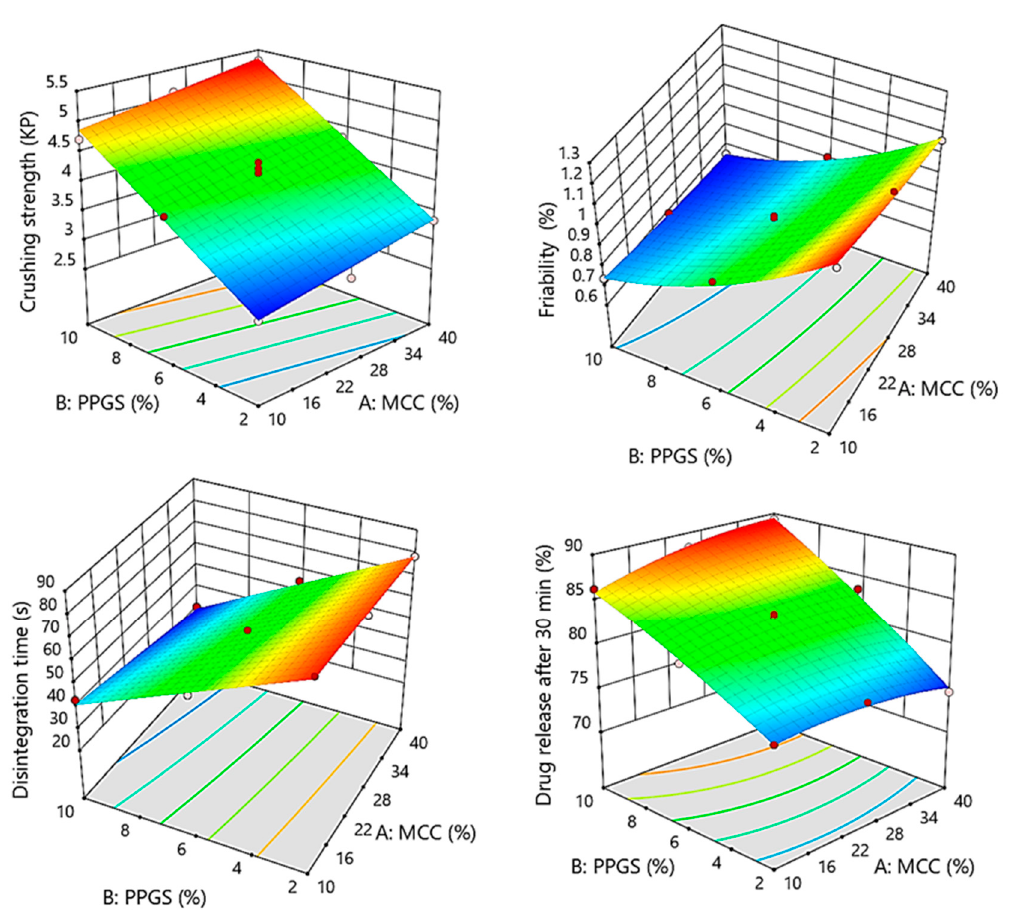
Figure 3. Response surface plots showing the influence of MCC (X 1 ) and PPGS (X 2 ) on measured MODTs responses; crushing strength (y 4 ), friability (y 5 ), disintegration time (y 6 ), and percent release after 30 min (y 7 ).